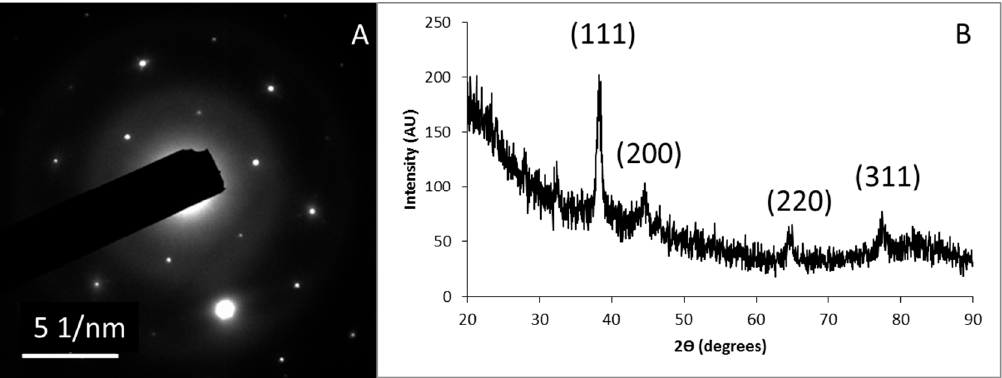
Figure 4. Crystalline nature of AgNPs. ( A ) Selected area electron diffraction (SAED) pattern of AgNPs produced with F2L and ( B ) X-ray diffraction (XRD) pattern.